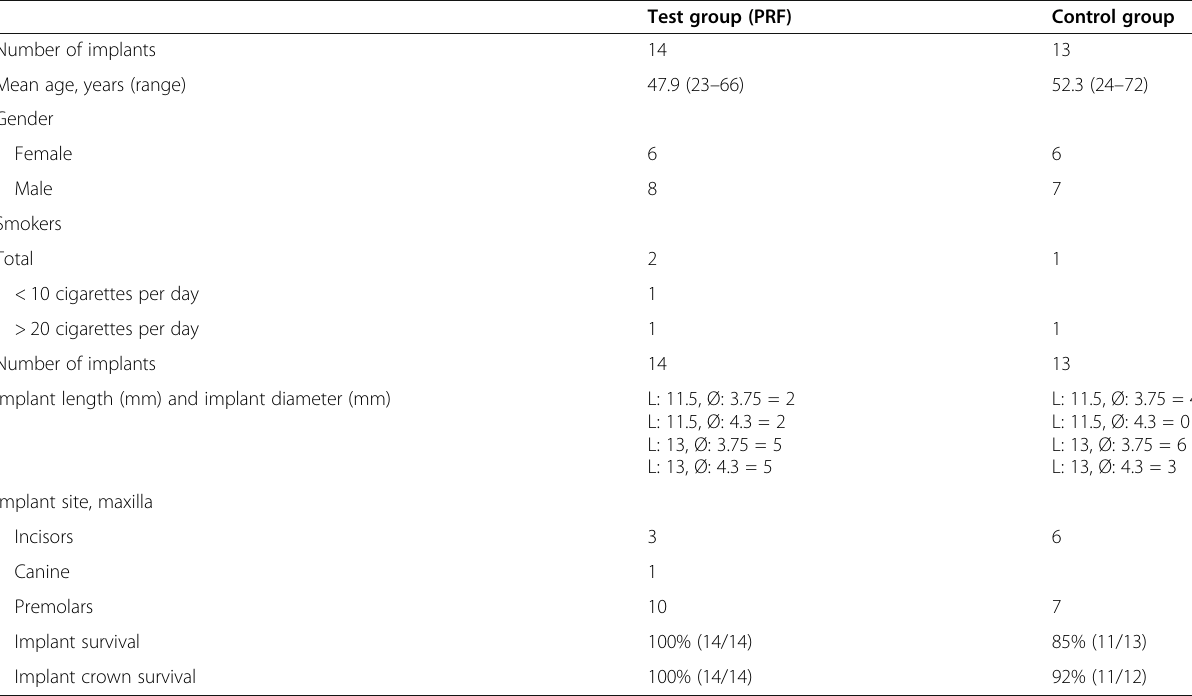
Table 1 Demographics and survival rates of implants and implant